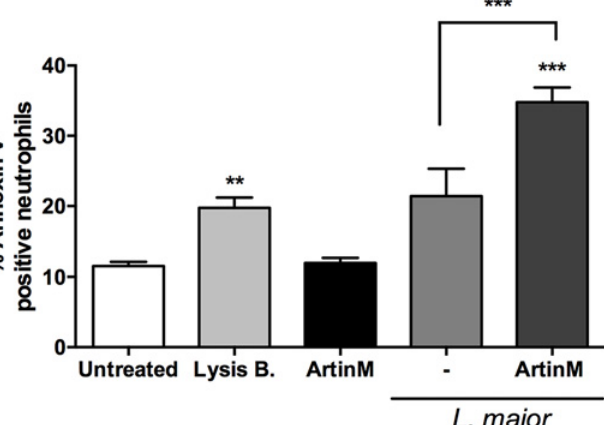
Fig 7. ArtinM induces early apoptosis of L . major infected neutrophils. Human neutrophils were incubated with medium (untreated), lysis buffer, ArtinM, or IL-8, and infected or not with L . major promastigotes (MOI 3:1). At 3 h post infection, cells were labeled with Annexin V -FITC and analyzed by flow cytometry. Data are expressed as mean of percentage of AnnexinV + neutrophils ± SD. ** p < 0.01;